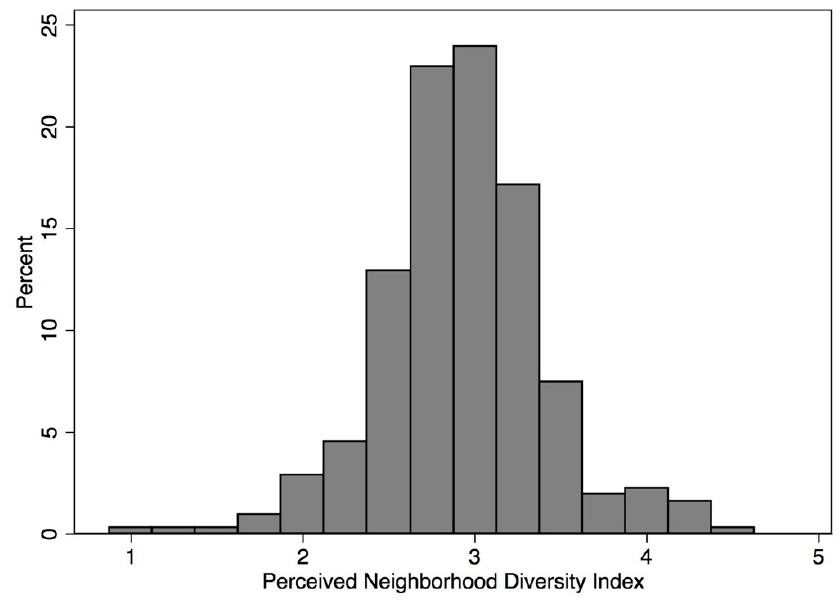
Figure 2. Distribution of perceived neighborhood diversity index responses.